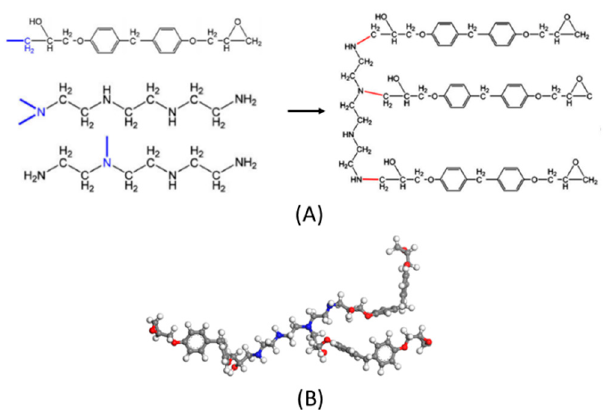
Figure 2. Normal crosslinking procedure and represented molecule. ( A ) crosslinking procedure of epoxy resin; and ( B ) representative molecule [19].